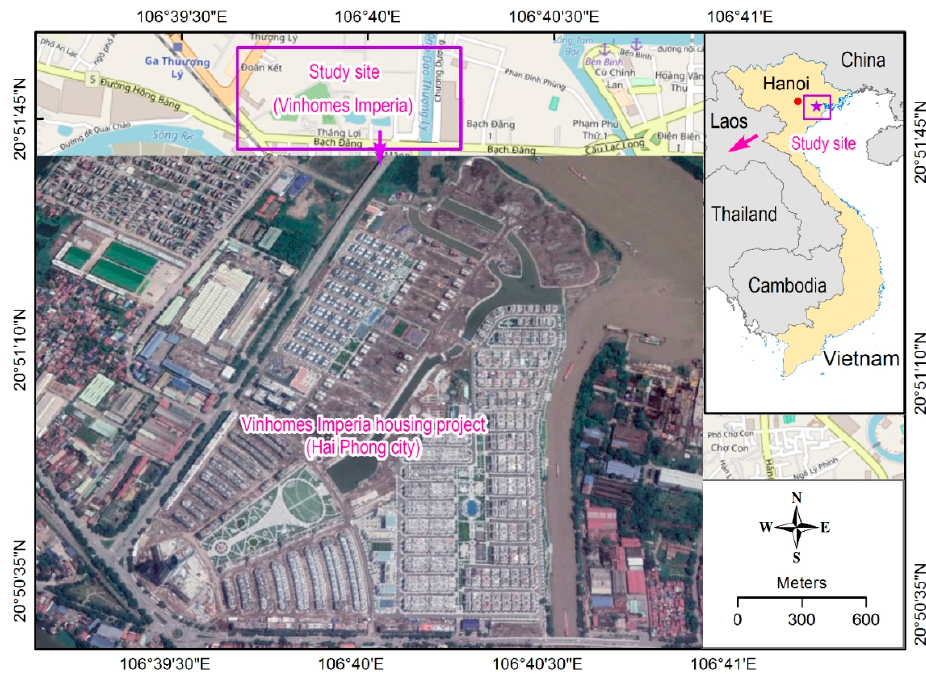
Figure 2. Location of the study area.